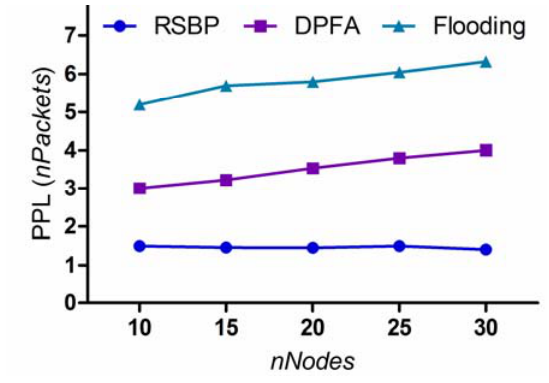
Figure 9. Packet processing load